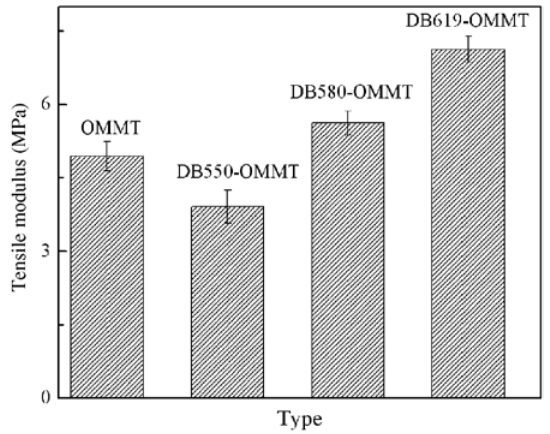
Figure 4 Different kinds of organophilic montmorillonite loading on the tensile modulus of the